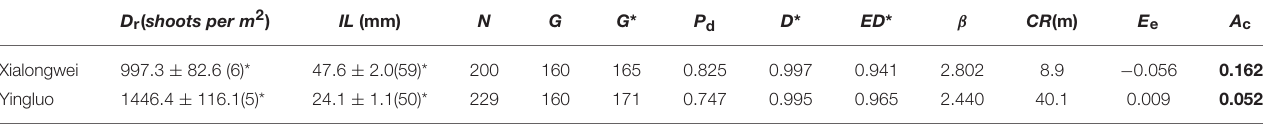
TABLE 1 | Parameters of clonal structure for two populations of Halophila ovalis . D r ( shoots per m 2 ) IL (mm) N G G * P d D * ED *